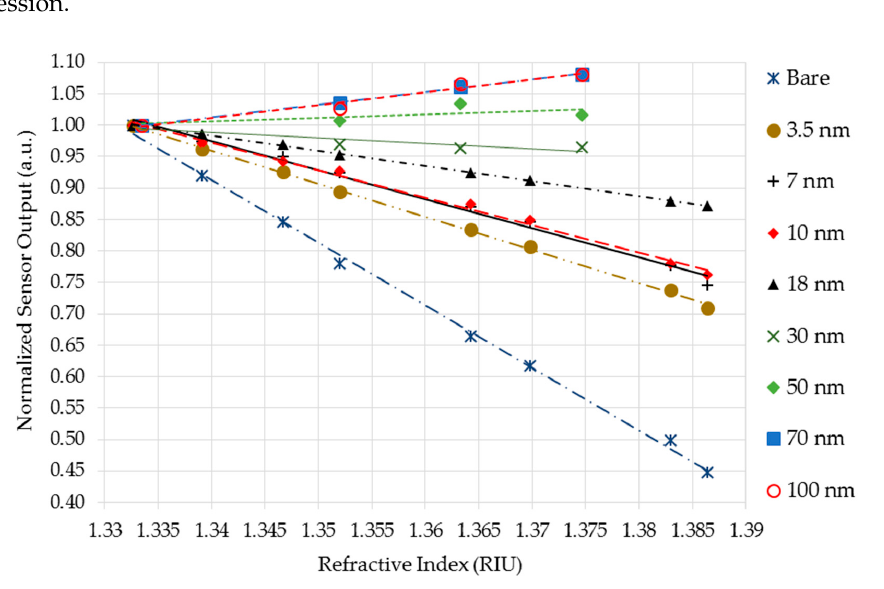
Figure 7. Averaged sensor responses for Setup 1 with reflective index (RI) variations for several gold layer thickness.